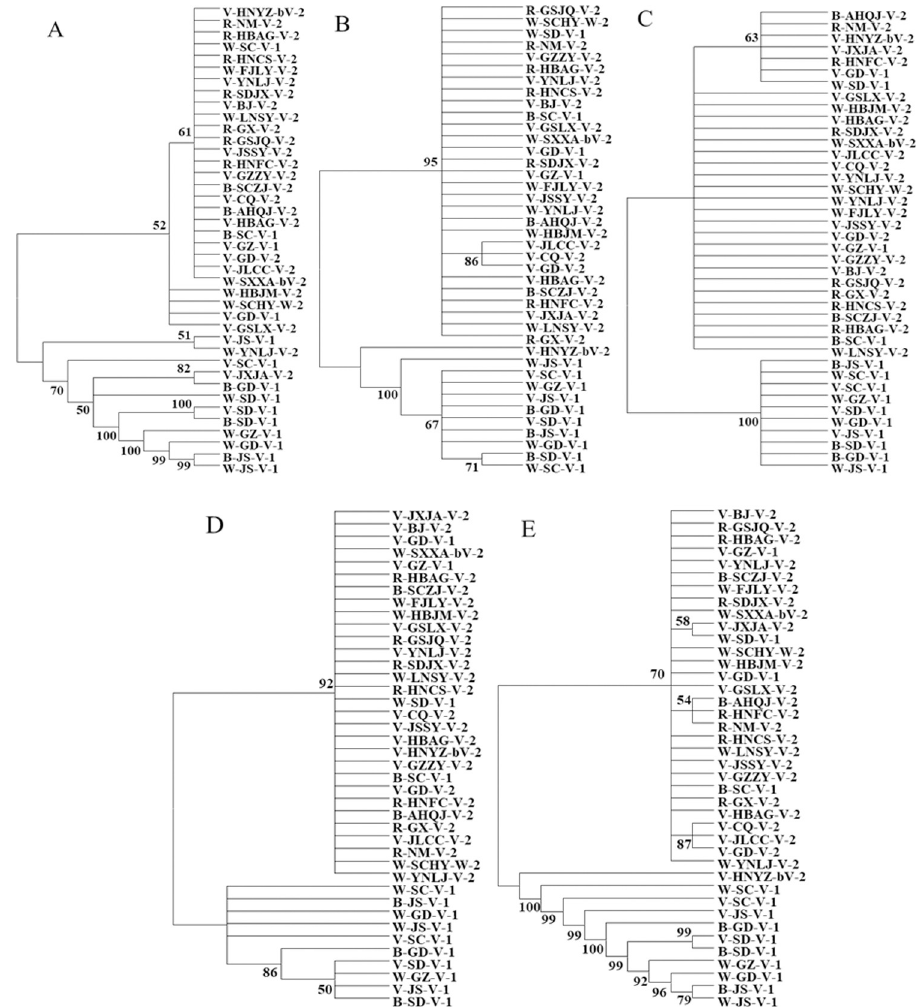
Fig 2. Phylogenetic trees based on the individual and combined intergenic spacers of the cultivated S . miltiorrhiza populations. A: ETS; B: psbA-trnH ; C: trnL-trnF ; D: ycf1-rps15; E: Combined sequence.